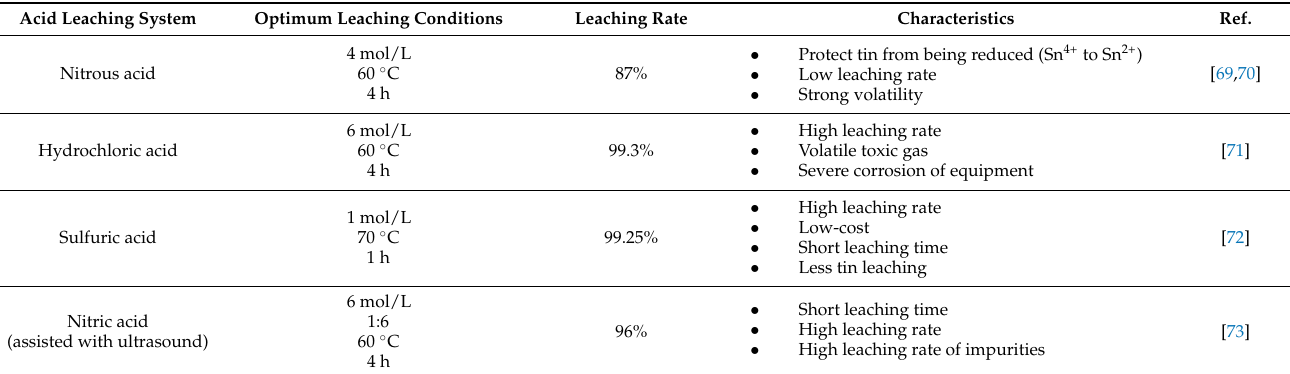
Table 3. Leaching effect of different acid leaching systems.